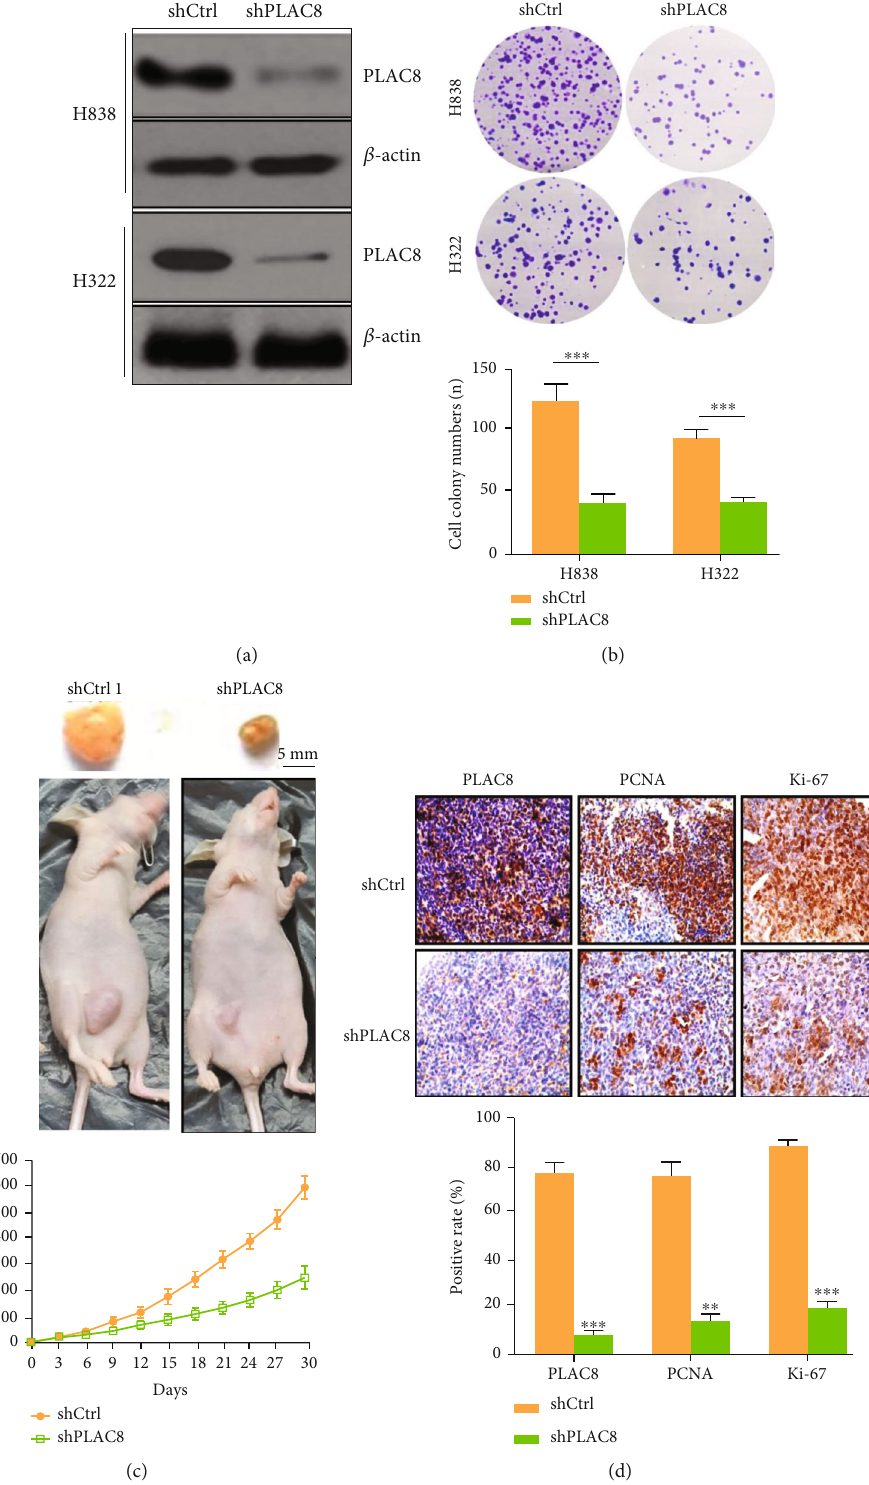
Figure 3: Downregulation of PLAC8 inhibits the proliferation of lung cancer in vitro and in vivo. (a) Protein levels con fi rm downregulation of PLAC8. (b) Downregulation of PLAC8 expression inhibits lung cancer cell clone proliferation. (c) PLAC8 downregulates inhibition of lung cancer proliferation in lung cancer mouse model. (d) Immunohistochemical detection of lung cancer in mice, ∗∗ p < 0 : 01 ; ∗∗∗ p < 0 : 001 . All these cell biological function assays were